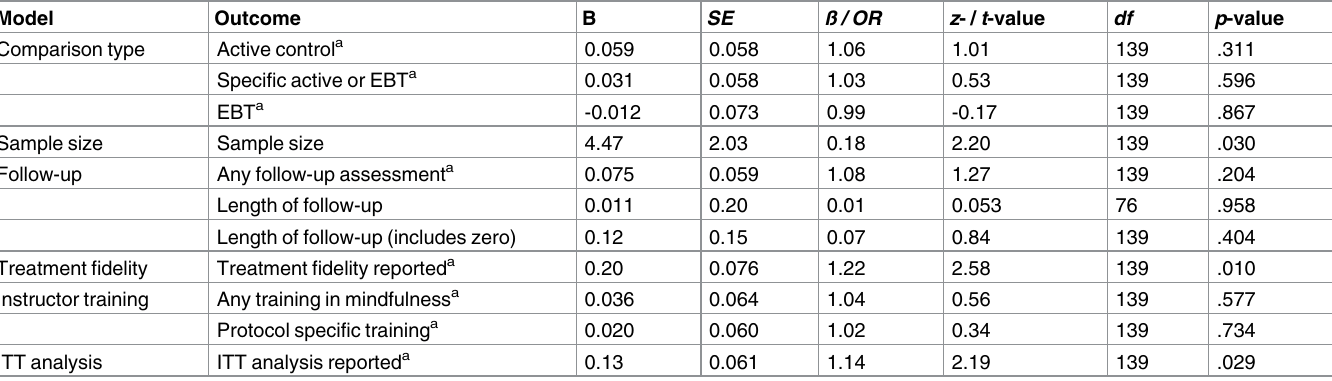
Table 4. Study quality predicted by year of publication (Teasdale et al. (2000) excluded).